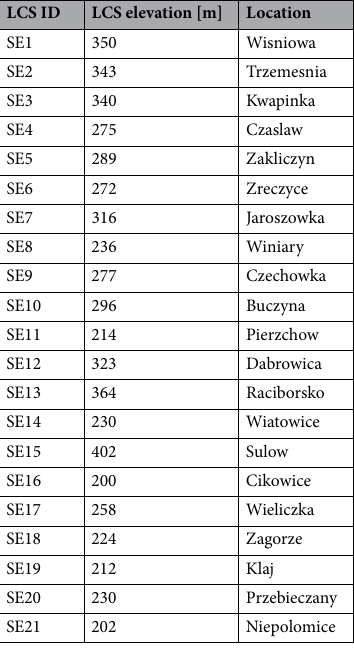
Table 5. Sensor location and elevation in the south-east section (outside the urban areas of